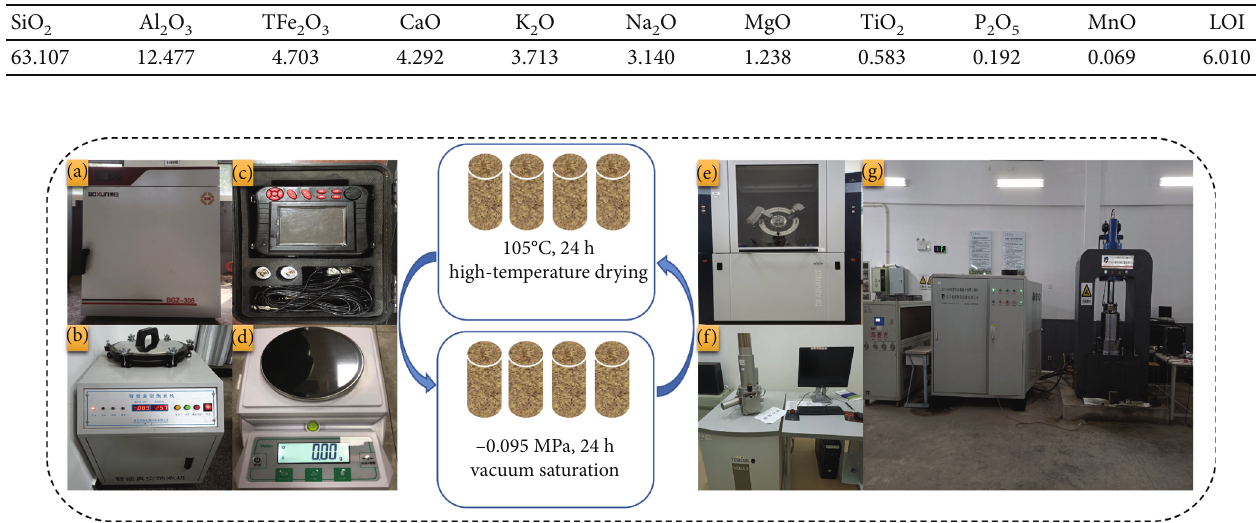
Table 1: Sample chemical composition (wt.%).